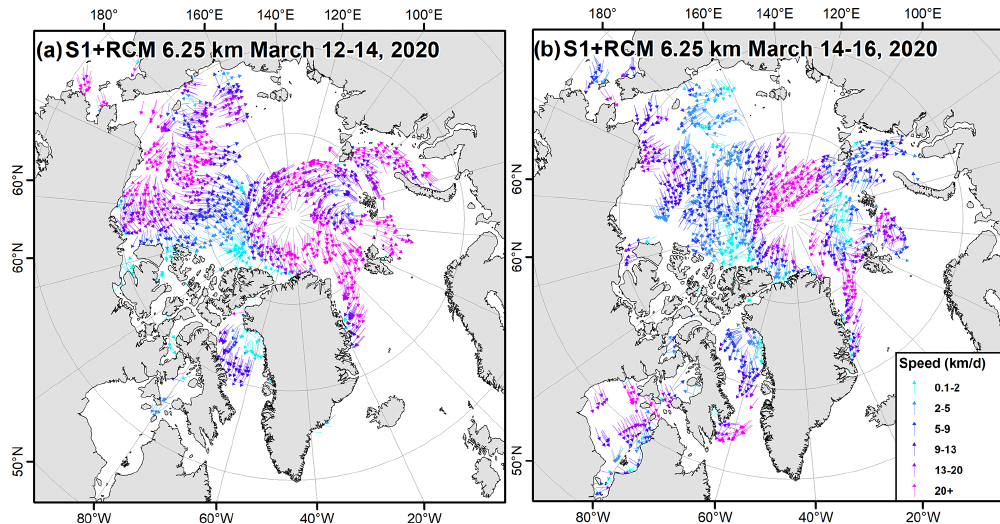
Figure 12. The spatial distribution of 6.25km 3d S1 + RCM sea ice motion on (a) 12–14 March 2020 and (b) 14–16 March 2020. Note that the white areas in the figure indicate either zero ice motion for the landfast ice or no ice motion information extracted (because of no SAR data, no ice, or no stable ice features).